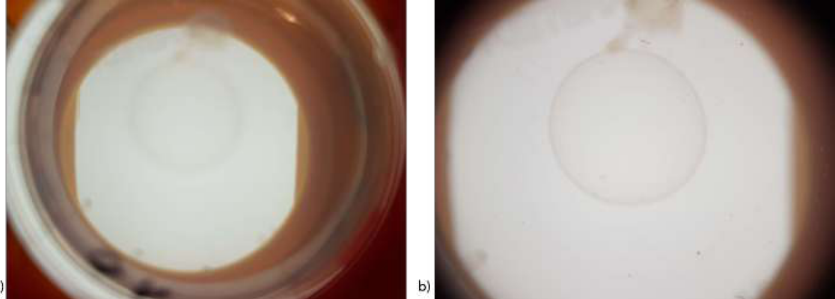
Figure 3. Corresponding example images ( a ) without magnification and ( b ) with magnification of C. elegans as captured with the system and a Samsung Galaxy S7 smartphone.